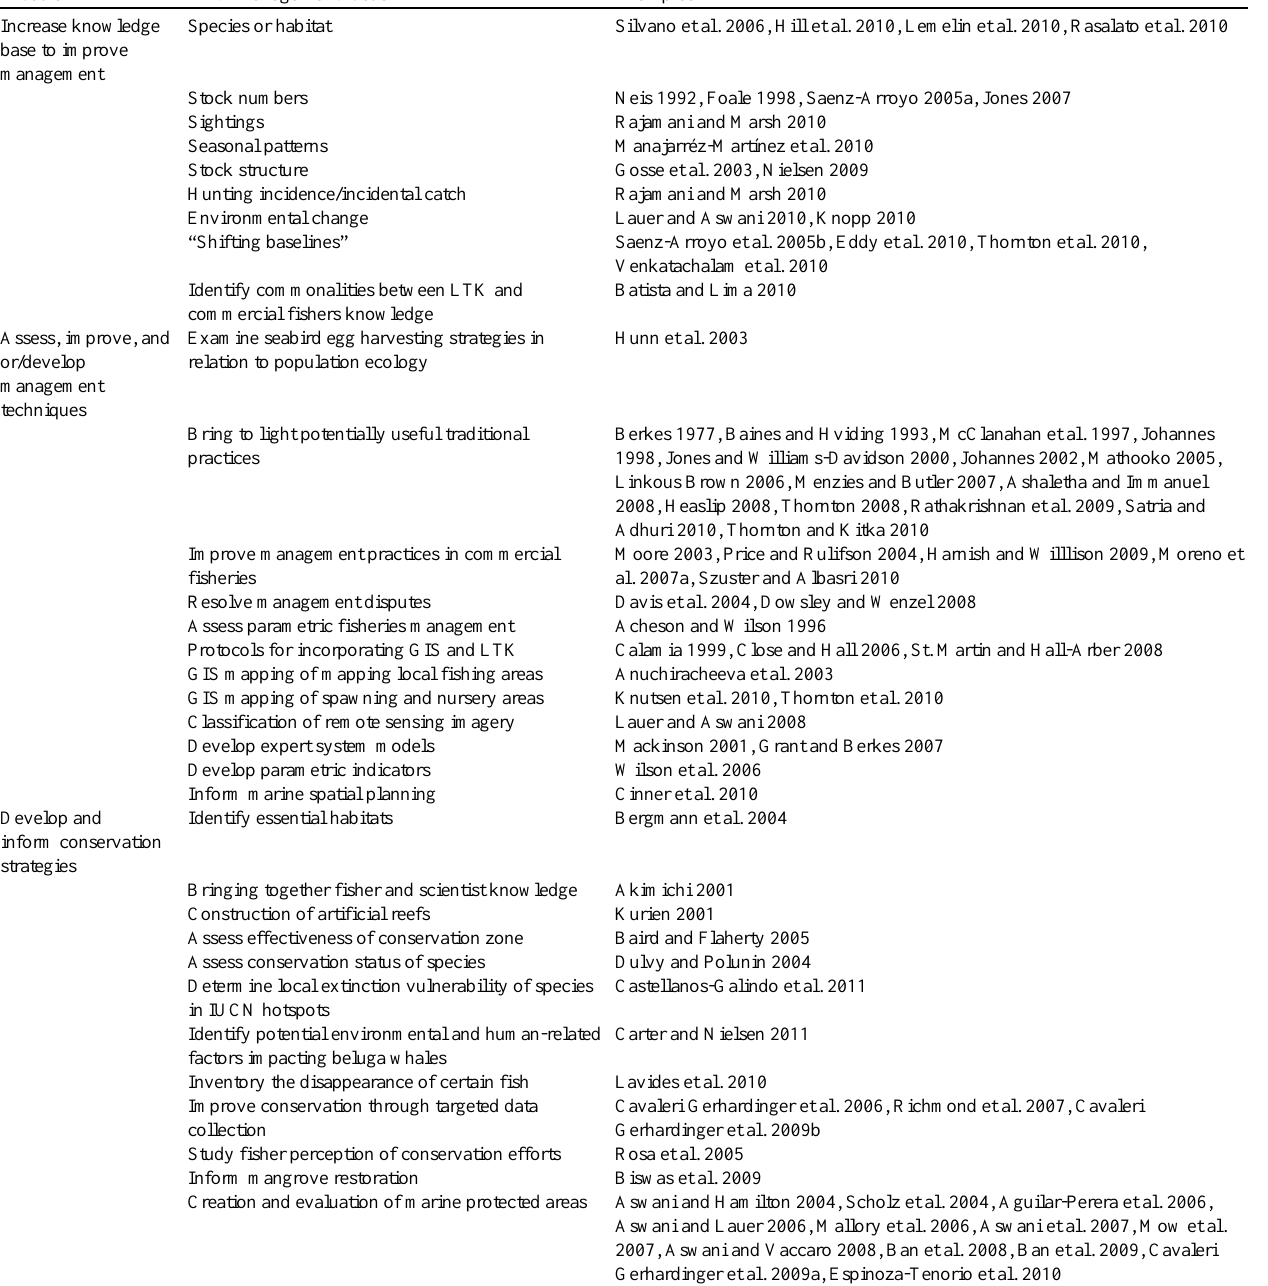
Table 2 . Management-focused marine LTK studies: examples from the